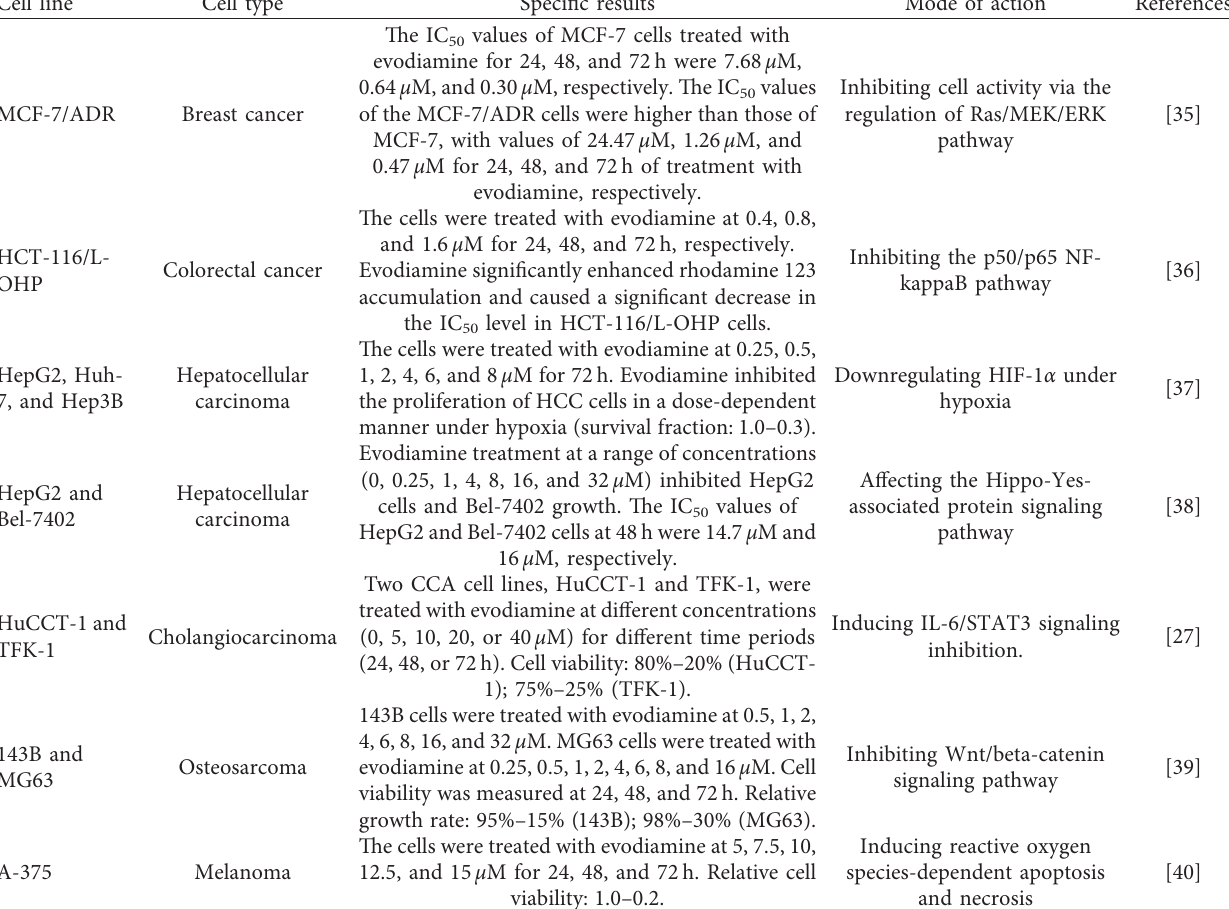
Table 1: Inhibition of tumor cell activity and proliferation by evodiamine in cancer cell lines.